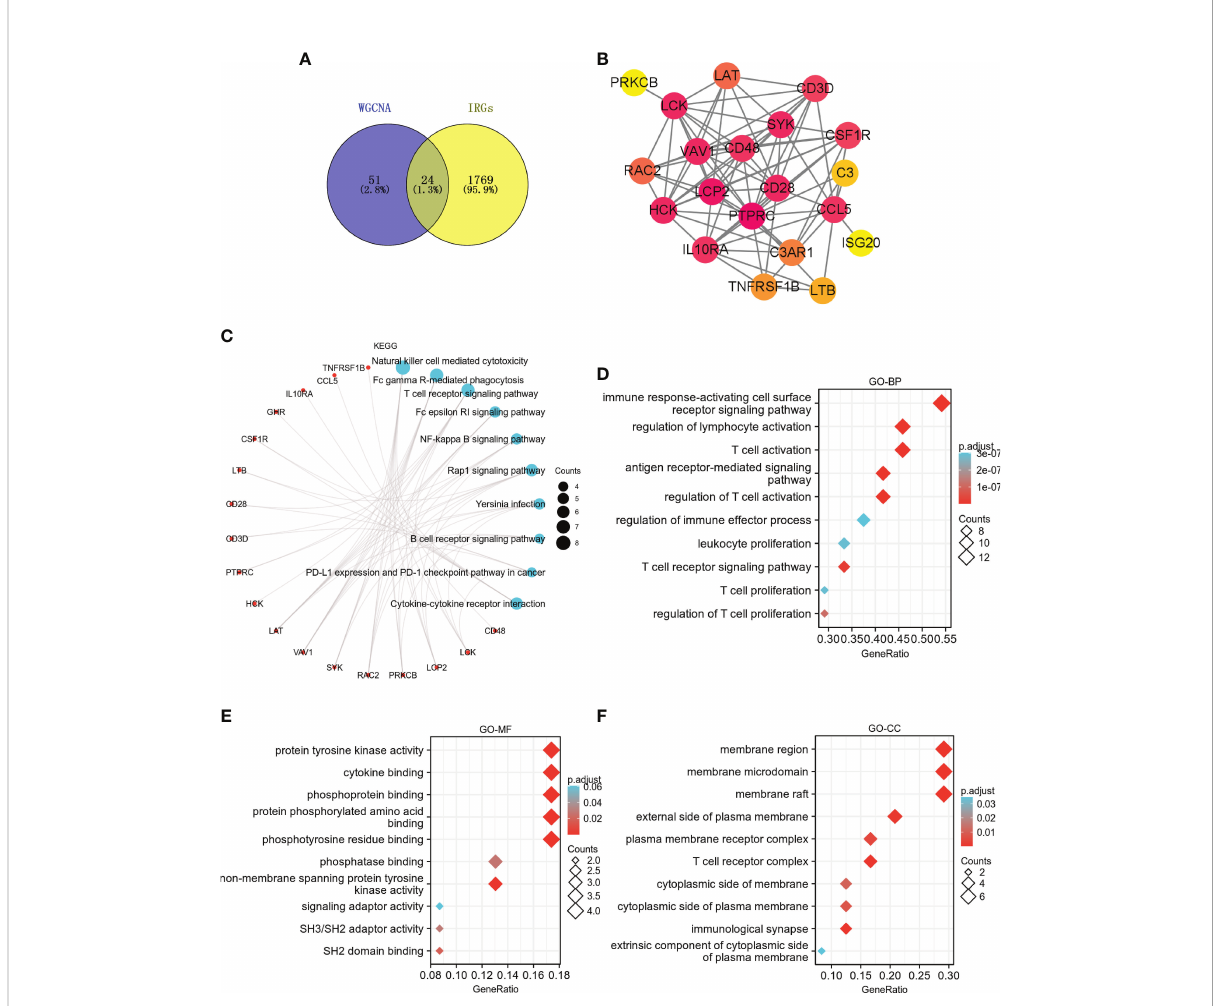
FIGURE 7 Identi fi cation and functional enrichment analysis of IRGs in key modules. (A) The Venn diagram shows the interaction between the key modules and IRGs. (B) PPI network of 24 IRGs. KEGG (C) , GO-BP (D) , GO-MF (E) , and GO-CC (F) enrichment analyses for the 24